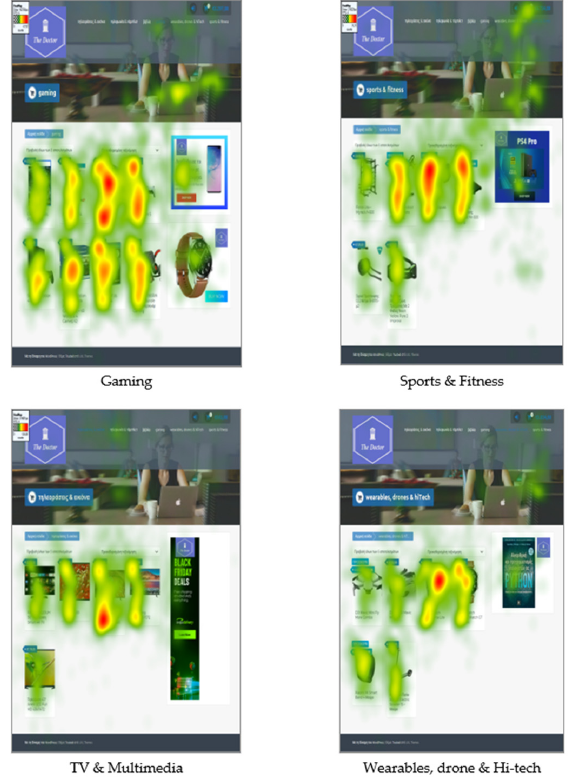
Figure 5. Heatmaps of banner advertisements with relevant content.